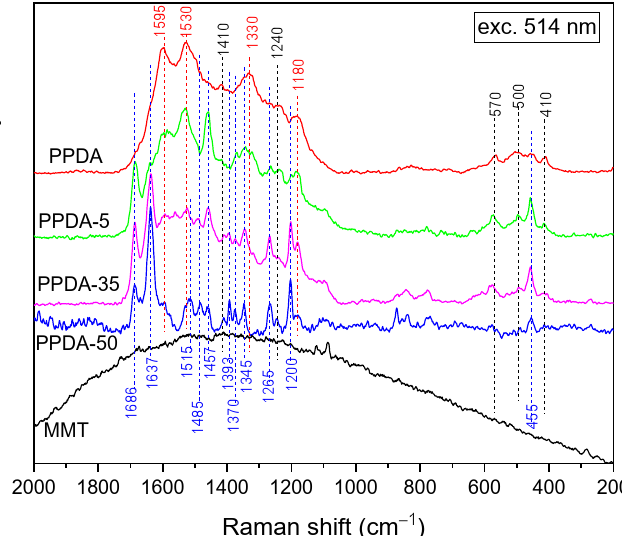
Figure 5. Raman spectra of selected MMT, PPDA and their composites excited with the 514 nm laser line. The spectra were baseline corrected, normalized and shifted for clarity.